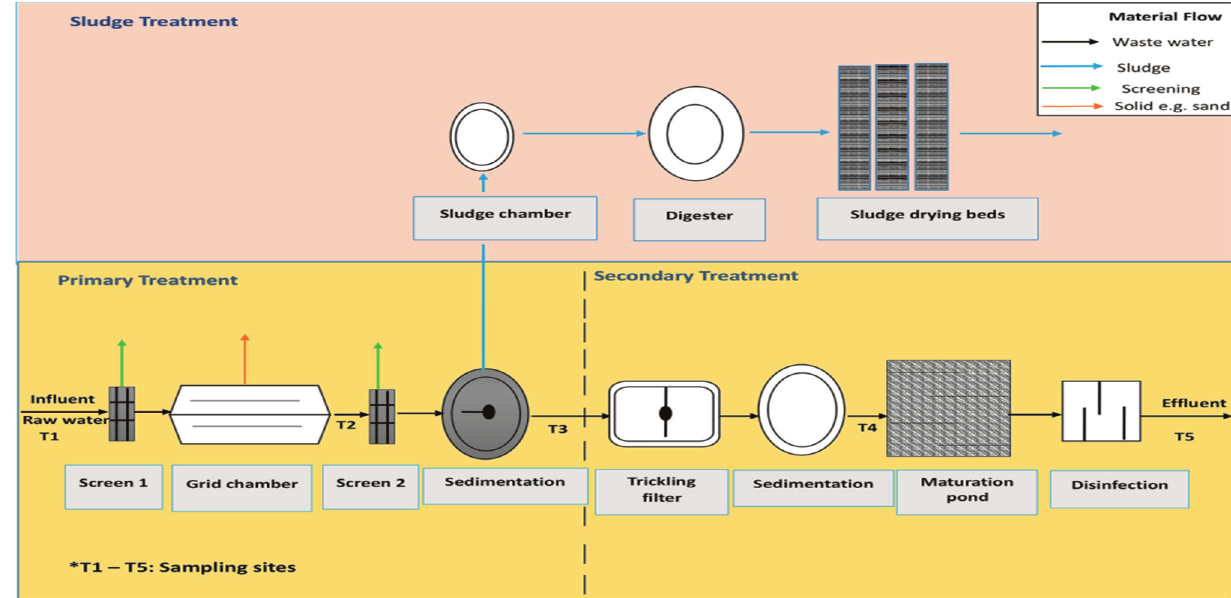
Figure 2. Basic processes in Thohoyandou